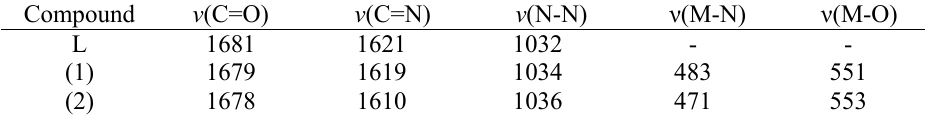
Table 2. Selected characteristic IR bands (400-4000 cm − 1 ) of ligands and their complexes